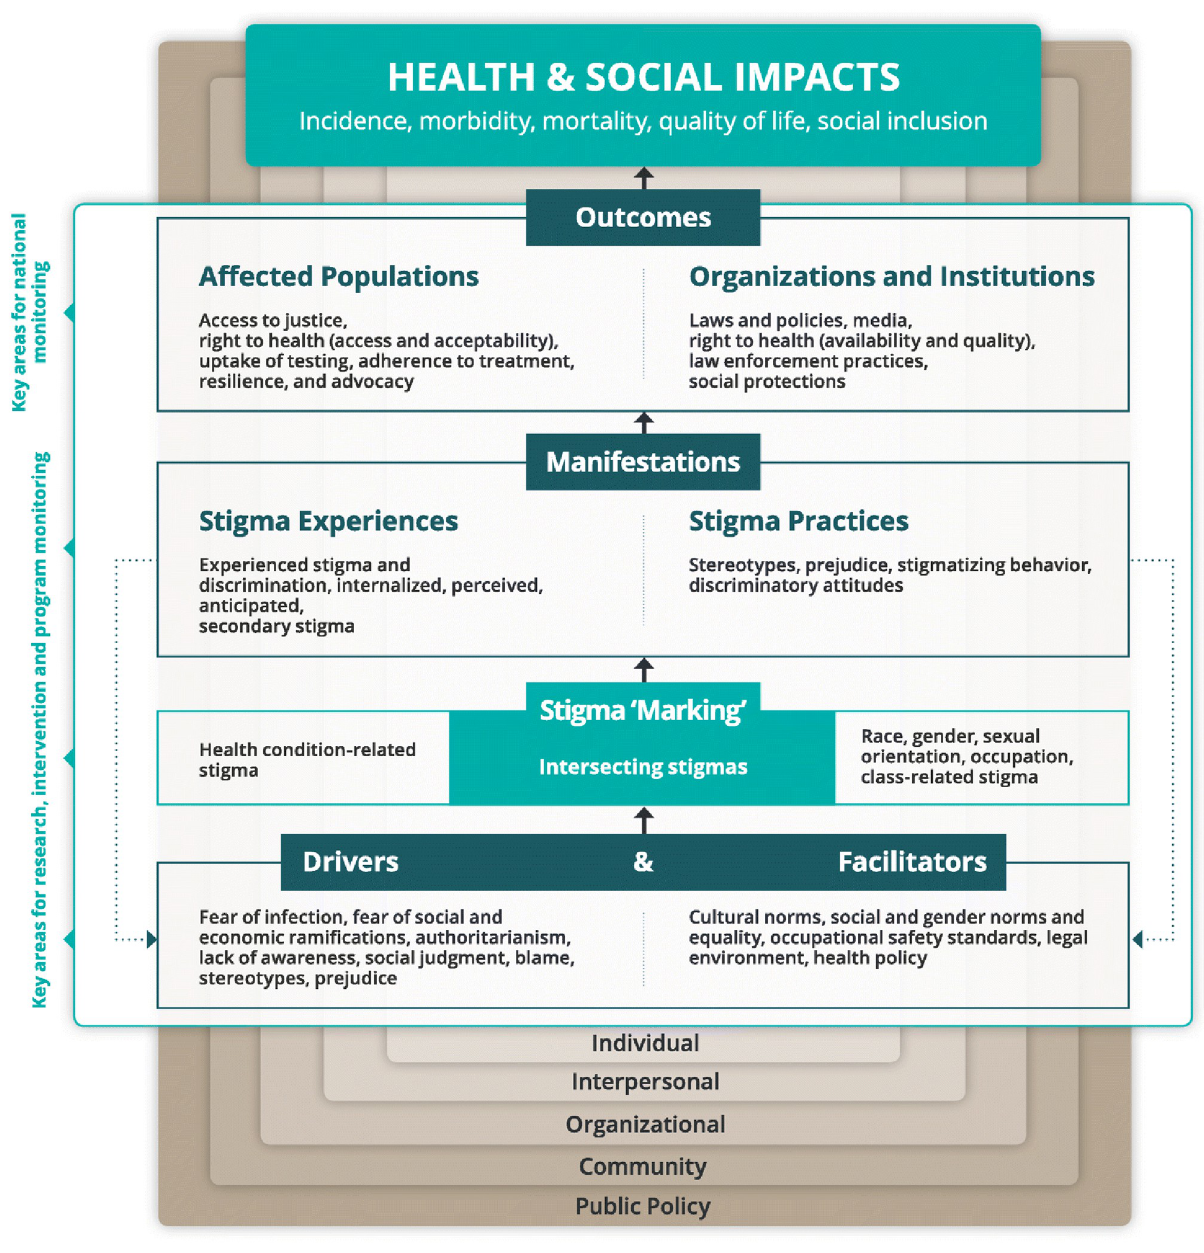
Fig 1. Health stigma and discrimination